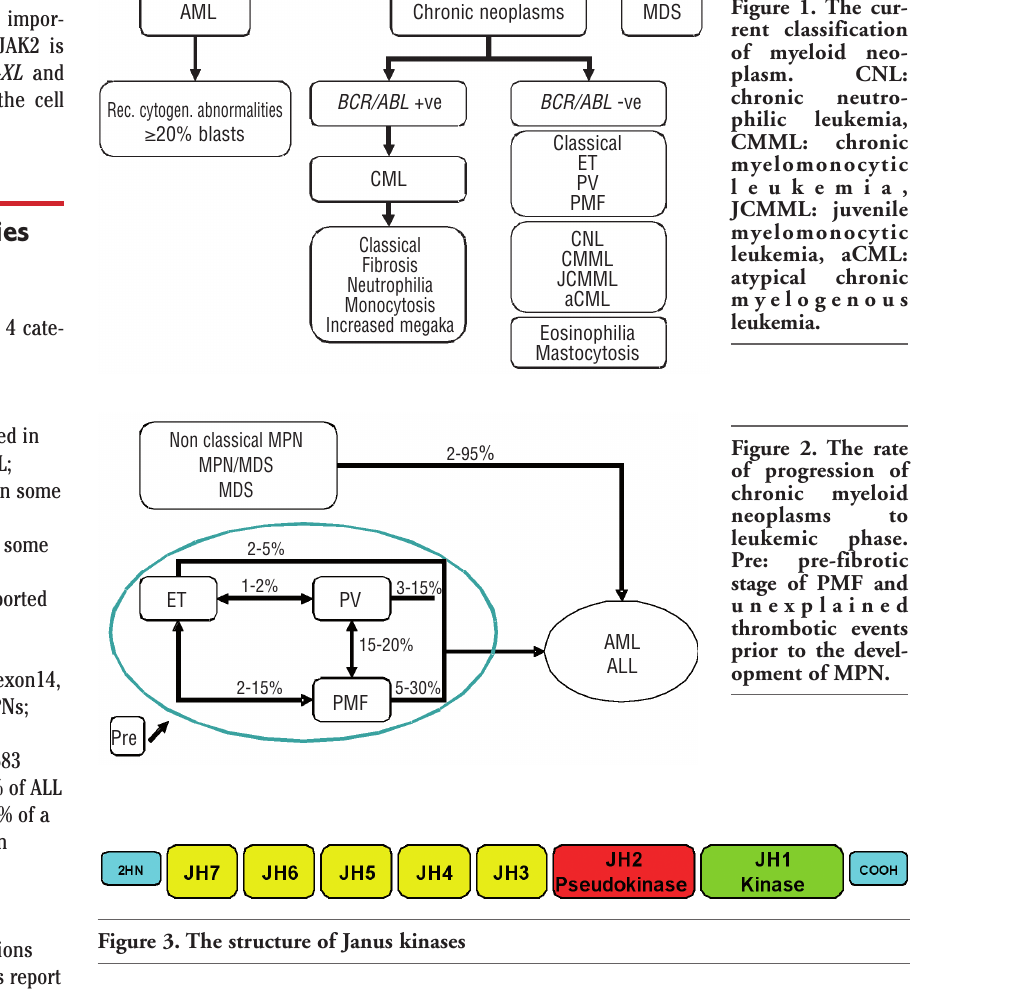
Figure 3. The structure of Janus kinases